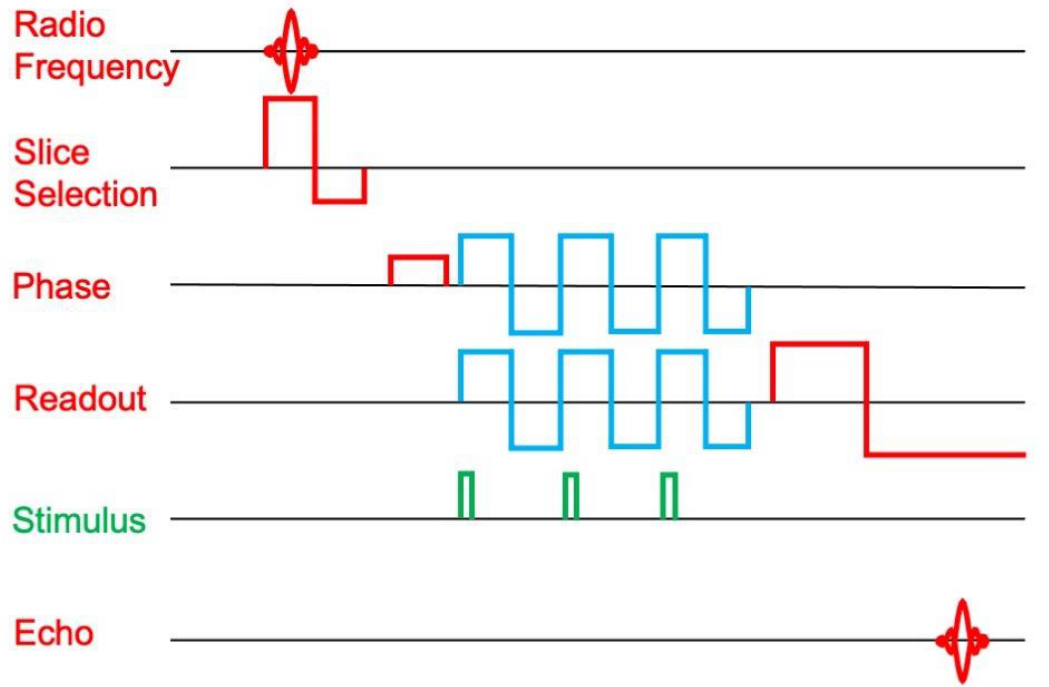
Figure 5. A traditional MRI gradient-echo pulse sequence with slice selection, phase encoding, and readout gradients (red). Truong et al. [16] applied additional oscillating gradients (blue) in synchrony with electrical stimulation of the median nerve at the wrist (green). Ideally, depolarization of the nerve action potential occurs during the positive phase of the oscillating gradient and repolarization during the negative phase. In that case, the echo is slightly different depending on whether or not the nerve is stimulated.